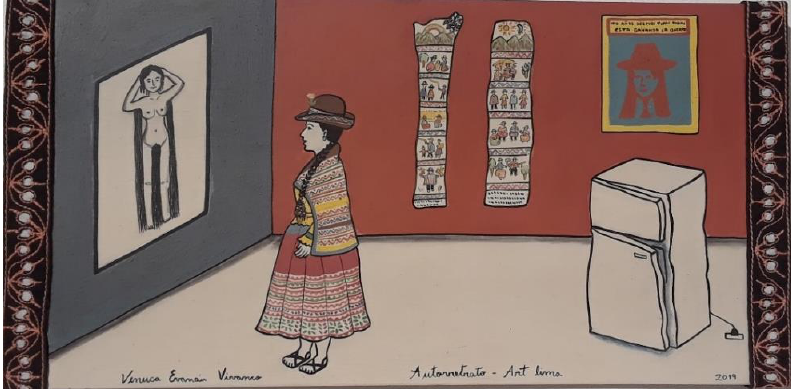
Figure 2. Venuca Evanán, Autoretrato-Art Lima , 2019, natural pigments on board, 20 cm × 36 cm. Collection of the artist. Photo credit: Gabriela Germana.